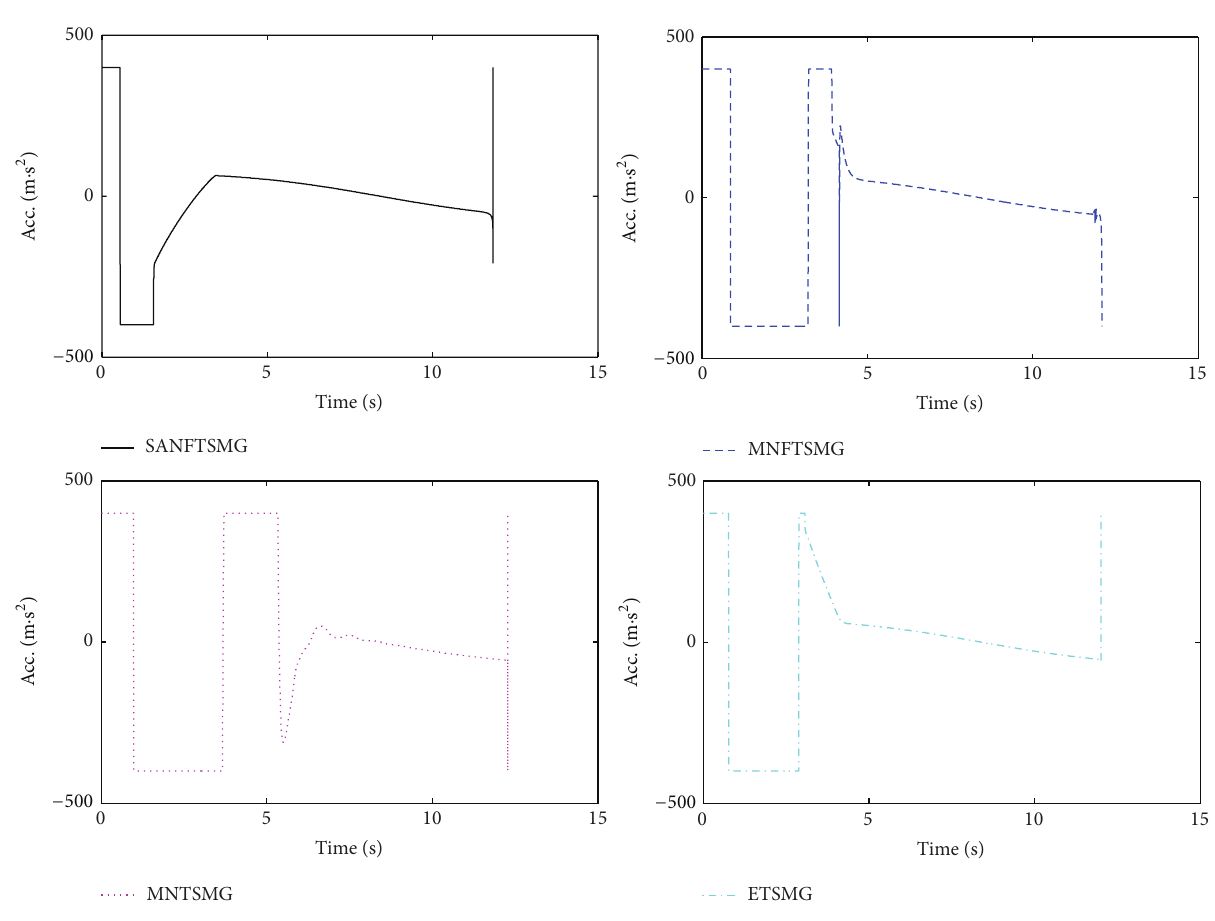
Figure 32: Trajectories of missile and target (Case 3).